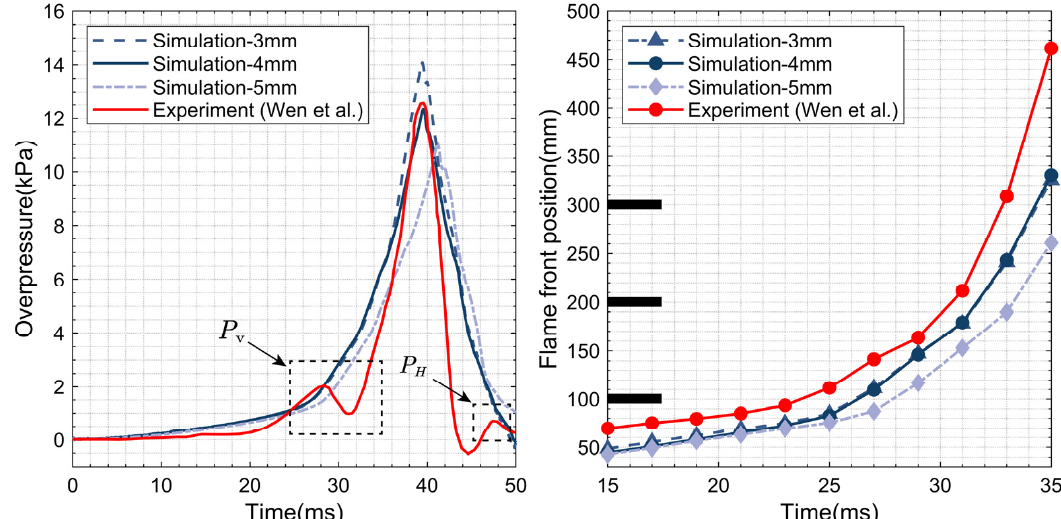
Figure 3. The comparison of the overpressure and the frame front position between the simulation with three meshes and the experiment from the ref. [35].